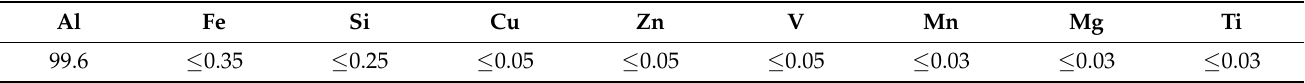
Table 2. Chemical composition of the samples (mass fraction).